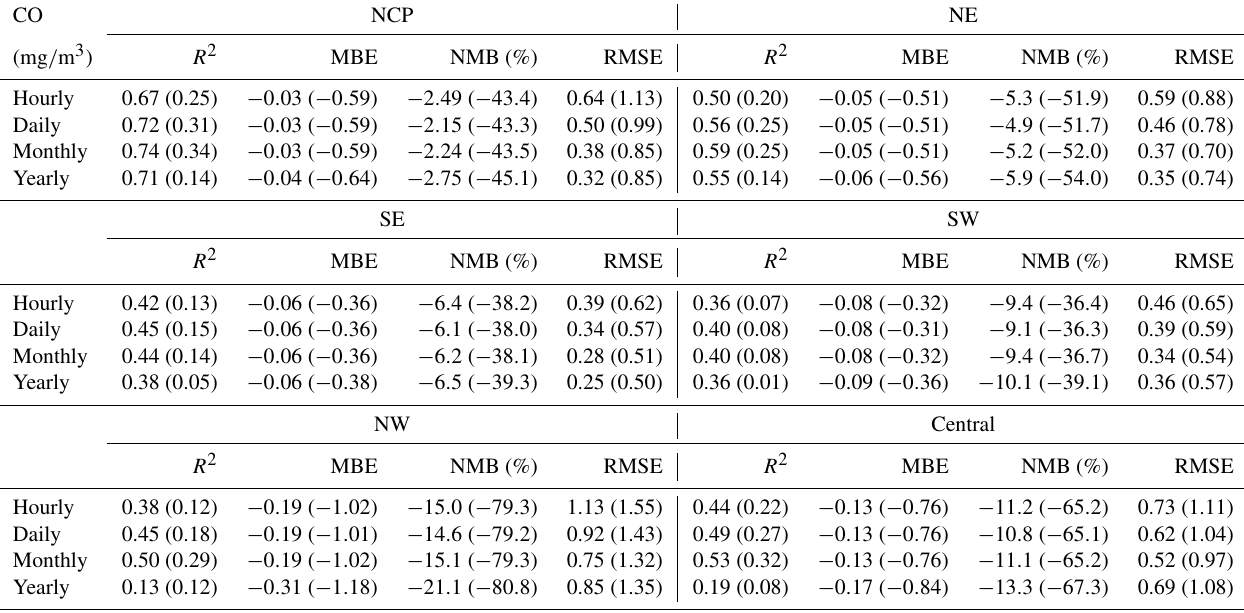
Table E5. CV results of the reanalysis (outside brackets) and base simulation (in brackets) for CO concentrations in different regions of China on different temporal scales.